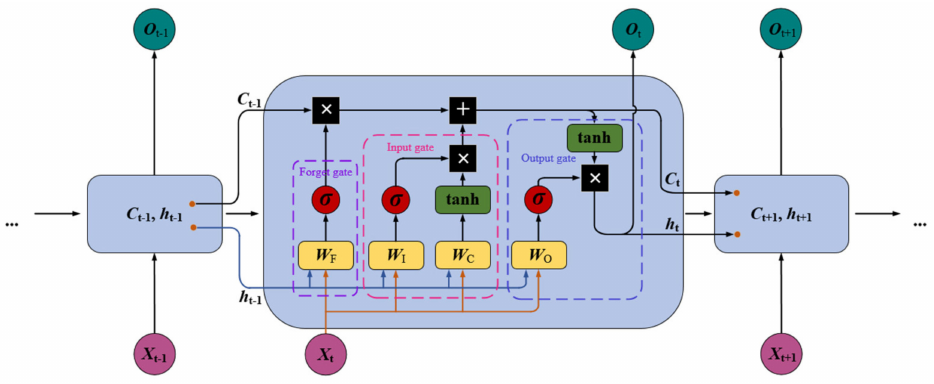
Figure 1. The architecture of classical